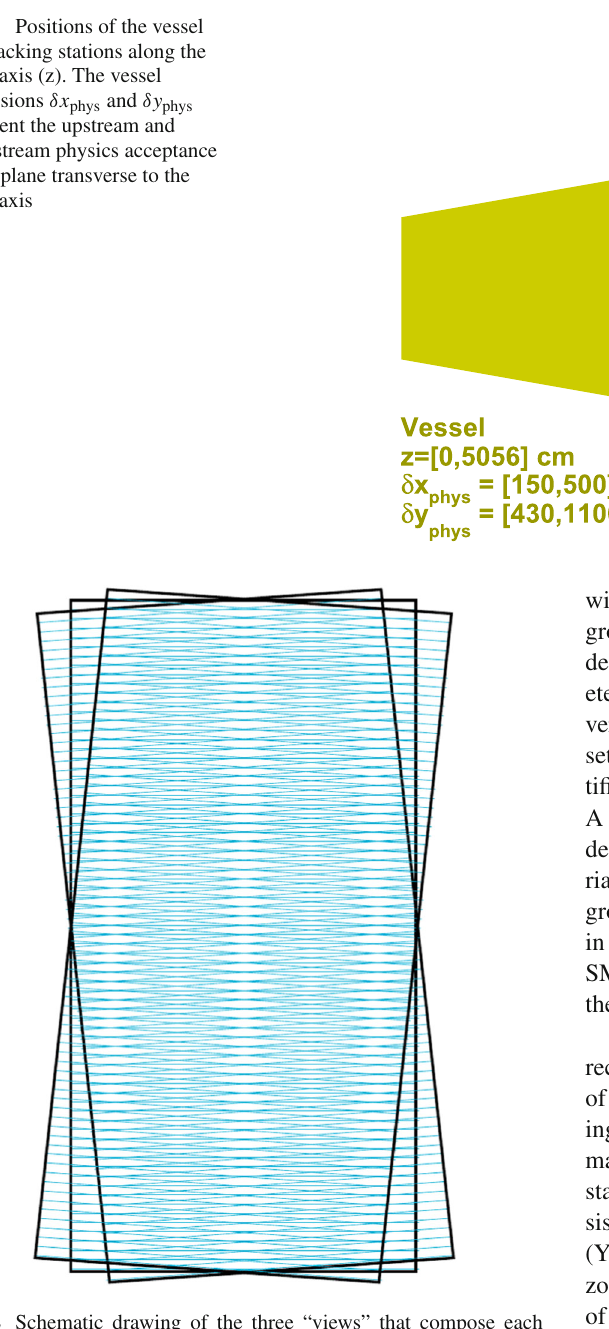
produced in the target [18,19], that would represent a seri- ous background in the search for hidden-sector particles. The detector is designed to fully reconstruct the exclusive decays of hidden particles and to reject the background down to below 0.1 events in the sample of 2 × 10 20 protons on tar- get